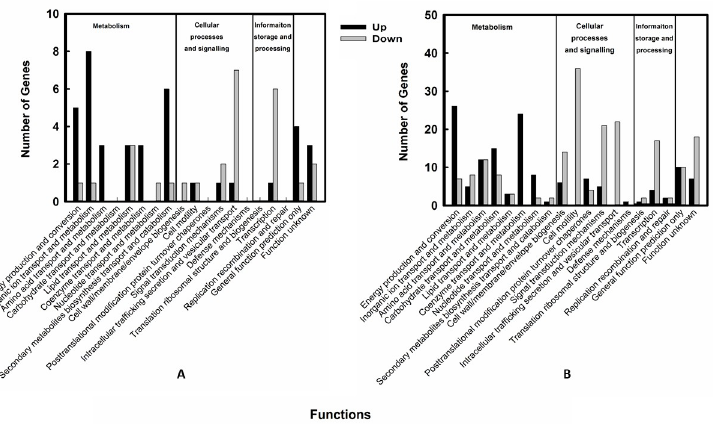
Fig 6. Overview of the differentially expressed genes according to their function. Genes significantly upregulated or downregulated at different concentrations of KCOH (A) control vs KCOH at 2 mg/mL and (B) control vs KCOH at 4 mg/mL in S . Enteritidis were grouped according to their Clusters of orthologous groups (COGs) functional categories. Since one gene can be classified into more than one COG class, the total number of COG assignments is greater than the number of differentially expressed